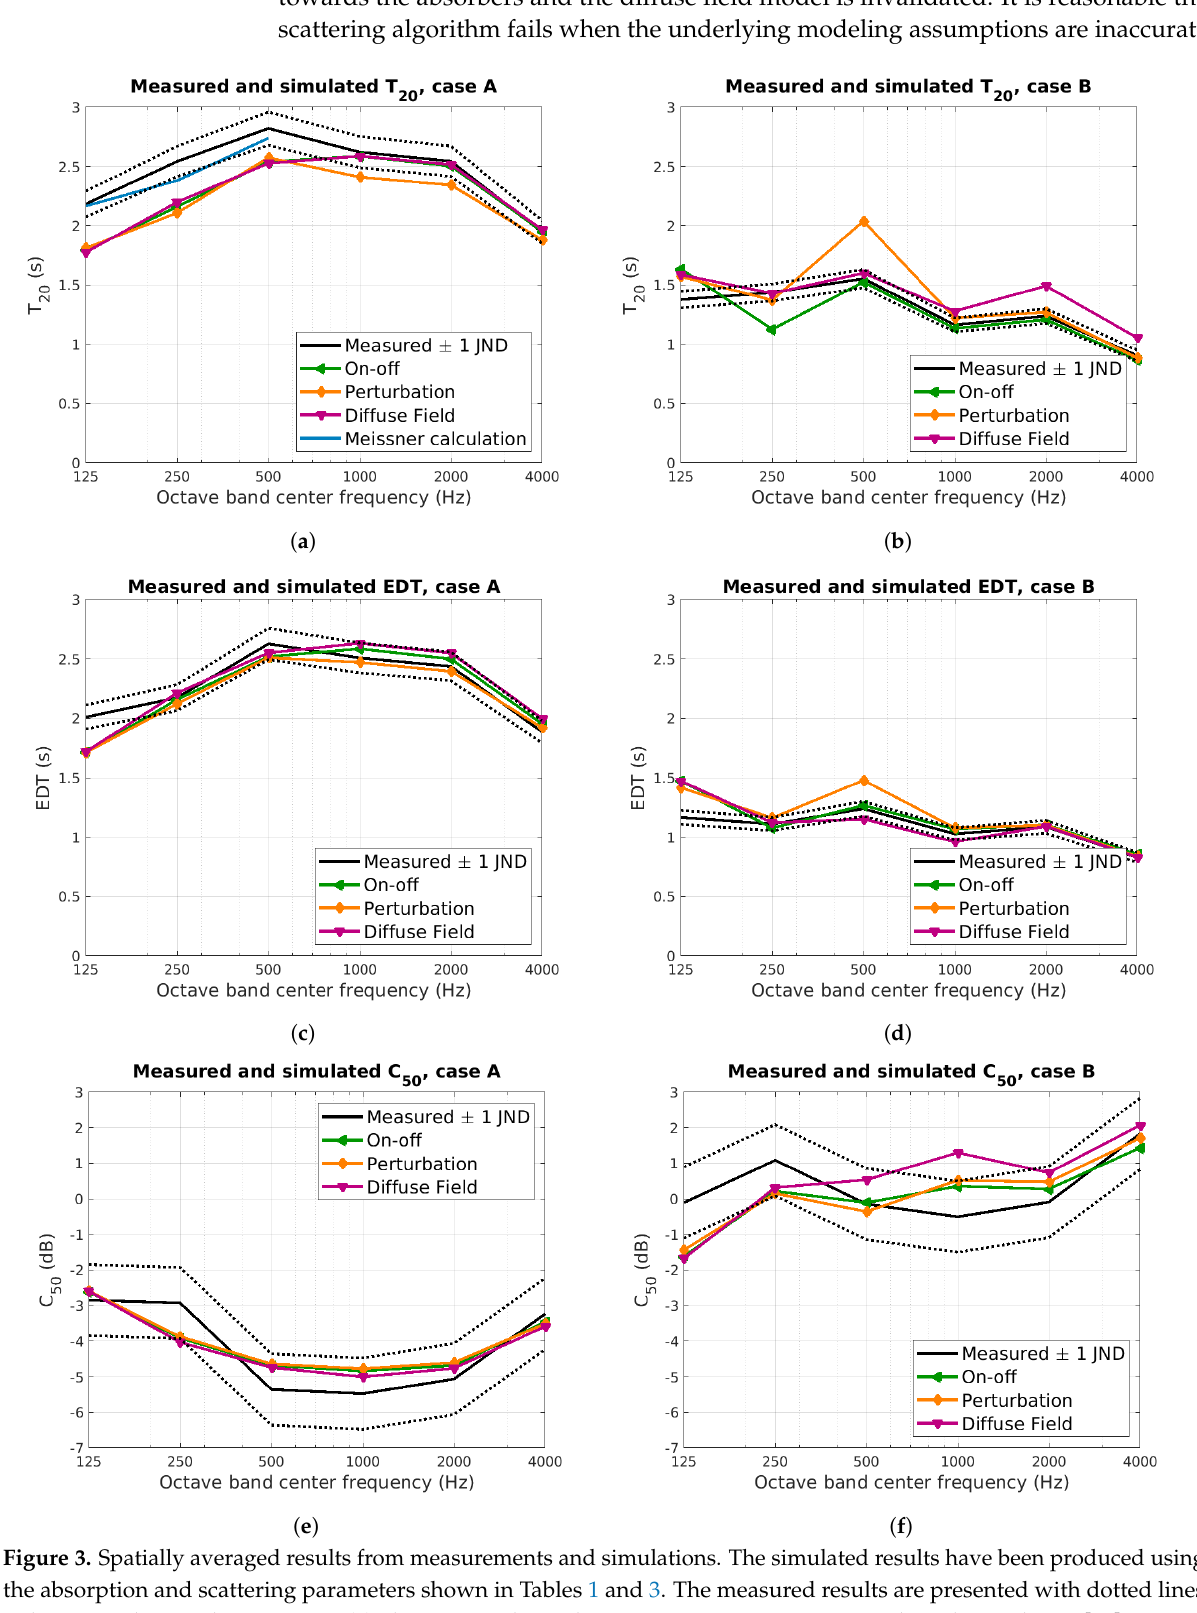
Figure 3. Spatially averaged results from measurements and simulations. The simulated results have been produced using the absorption and scattering parameters shown in Tables 1 and 3. The measured results are presented with dotted lines indicating values within 1 JND. In ( a ), the estimated reverberation time using Meissner’s algorithm is shown